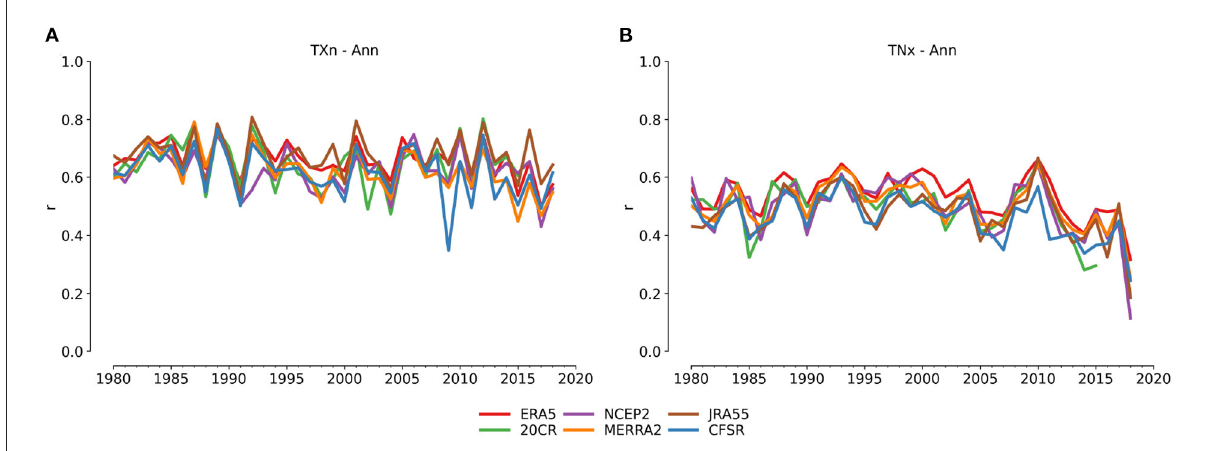
FIGURE2 Spatial rank correlation of the coverage-matched reanalyses datasets against HadEX3 for (A) TXn and (B) TNx annual